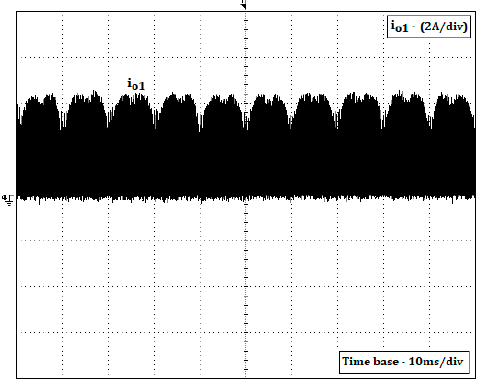
Figure 16. Result of the current flowing to the batteries (i o1 ).